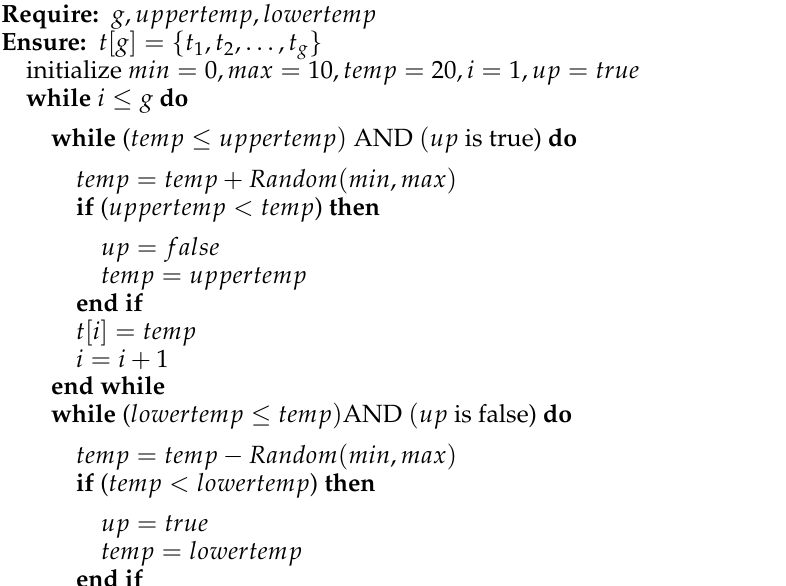
Algorithm 7 Creating simulated temperature data